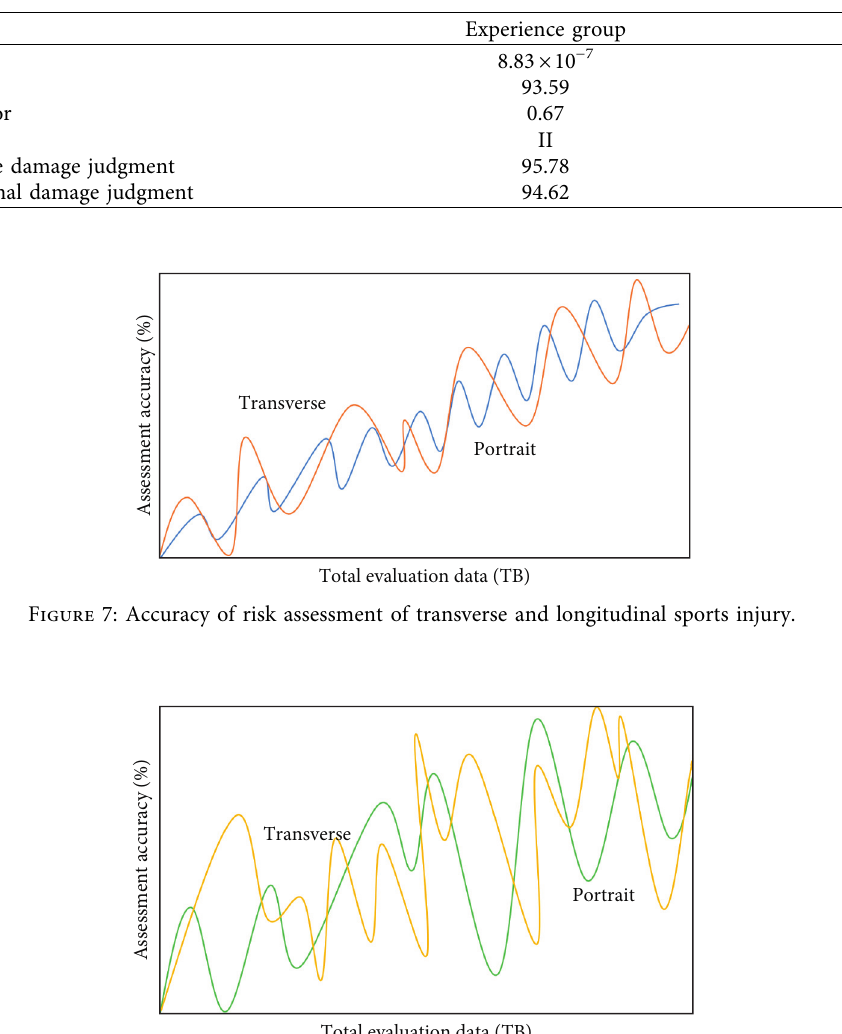
Table 4: Experimental parameter setting table.